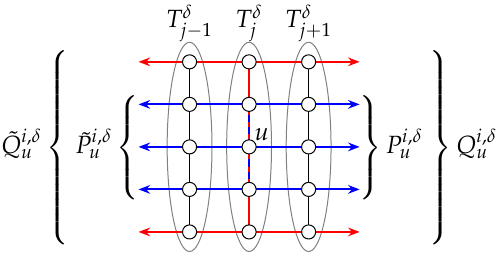
Figure 3. Illustrating the paths of P i , δ u , ˜ P i , δ u , Q i , δ u and ˜ Q i , δ u in the case of a T ( 2,5 )